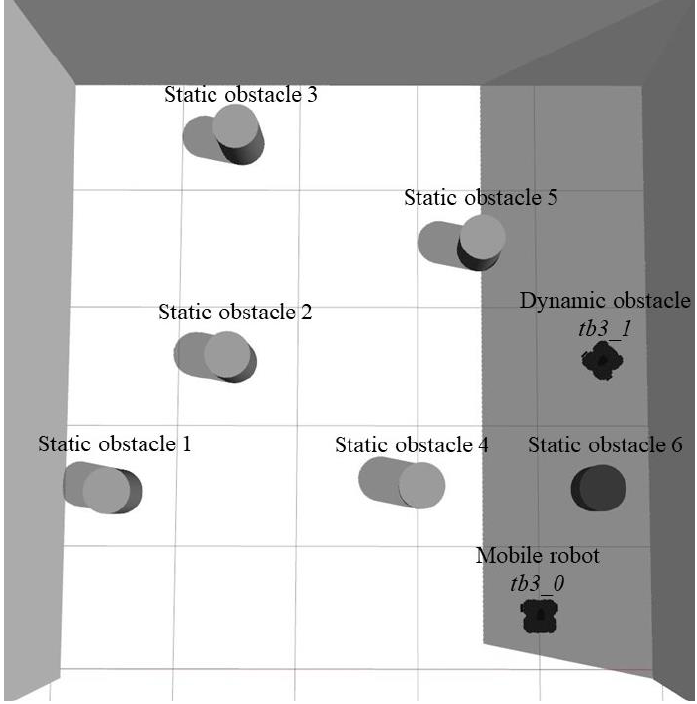
Figure 7. Simulated environment scenario 3 with labels.